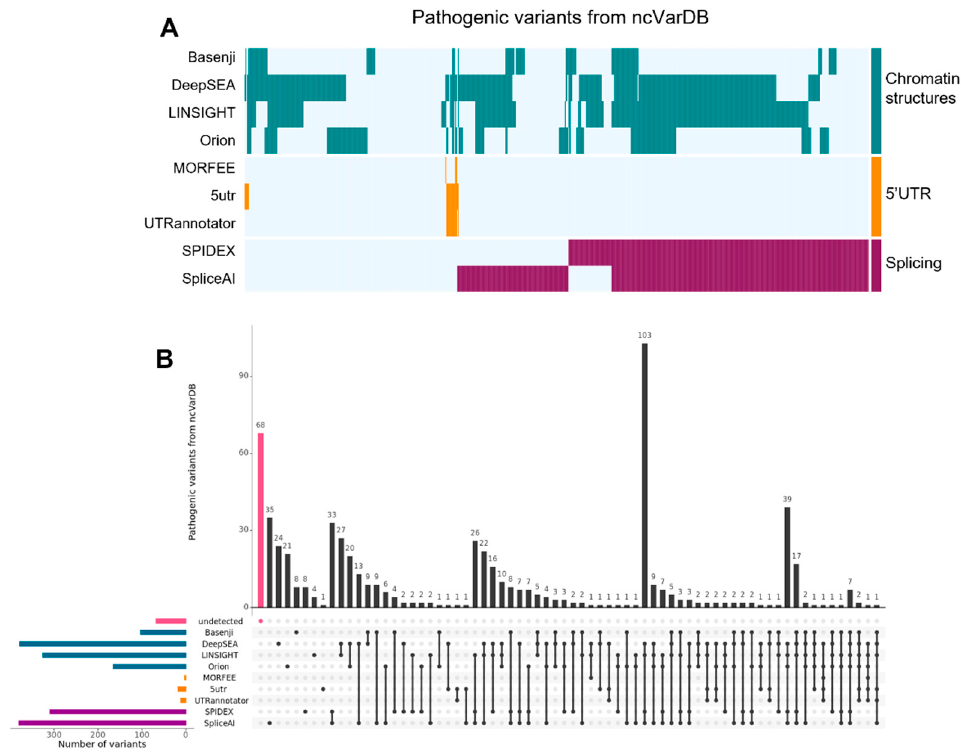
Figure 2. Pathogenic ncVarDB variants (excluding those on chrM) correctly marked as pathogenic by the listed tools. ( A ) The heatmap shows the pathogenic variants (y-axis) detected by each tool (x-axis). A cell is colored whenever a variant is correctly identified as pathogenic. The color scale represents the genomic feature considered by the tools: green, NCVs affecting chromatin structures; orange, variants in 5 ′ UTRs; purple, variants affecting the splicing. ( B ) Upset plot showing the co-occurrence of pathogenic non-coding variants from ncVarDB identified by each tool. The horizontal bars show the total number of pathogenic non-coding variants detected by each tool. The vertical bars show the occurrence or co-occurrence of pathogenic non-coding variants identified through every combination of tools, and the number at the top identifies the cardinality of the set. The black dots and lines show the combination of tools that make up each set.